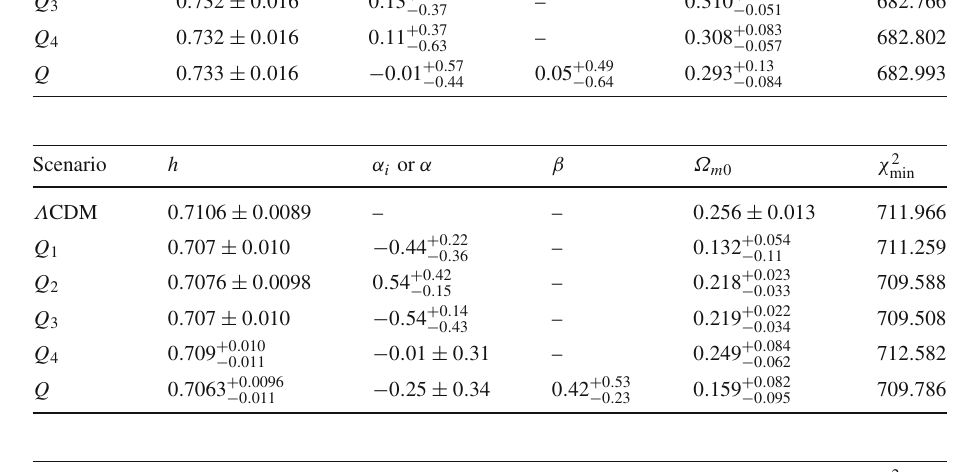
Table 4 Best fit parameters and 1 σ error for the analysis using JLA + H 0 . As a comparison we show the fit for ω CDM